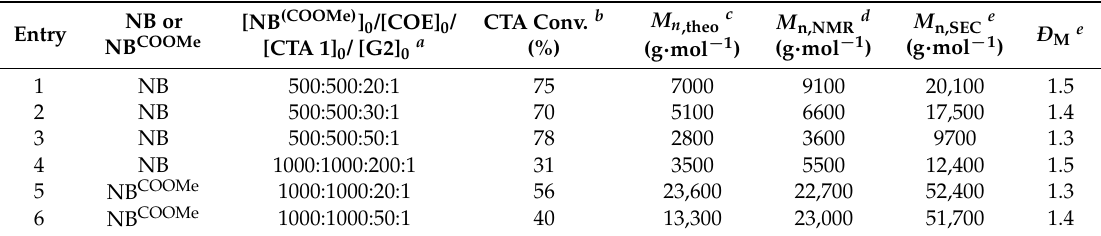
Table 2. ROMP/CM of COE with NB or NB COOMe (equimolar mixtures) catalyzed by G2 in